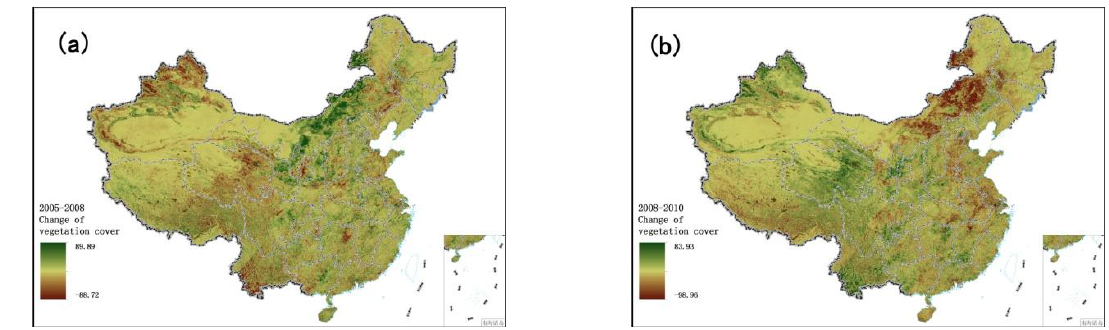
Figure 19. Change in vegetation cover over China during 2005–2010. ( a ) 2005 to 2008; ( b ) 2008 to 2010.